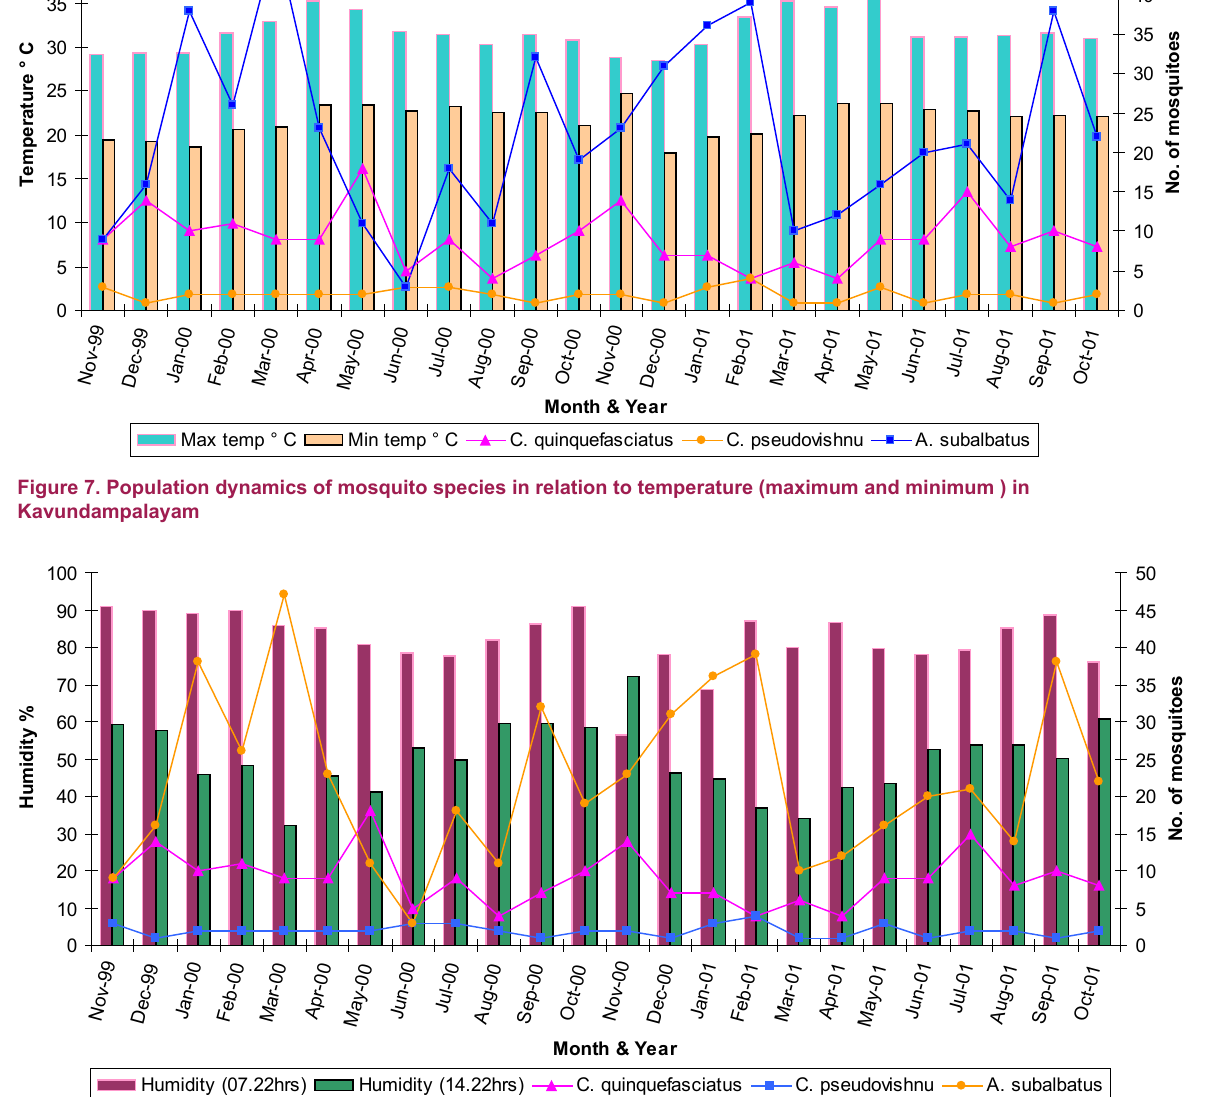
Figure 8. Population dynamics of mosquito species in relation to humidity (0722 & 1422 hr) in POPULATION DYNAMICS OF MOSQUITO SPECIES IN RELATION TO